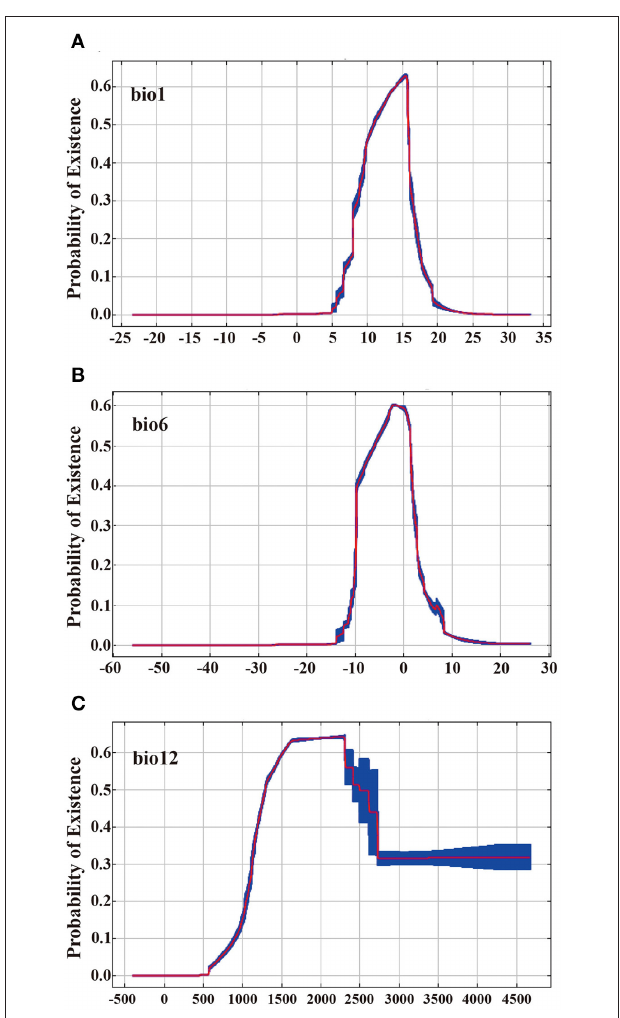
FIGURE 3 | Response curves between the probability of presence and climate variables (10 runs). (A) response curves between the probability of presence and bio1. (B) response curves between the probability of presence and bio6. (C) response curves between the probability of presence and bio12. Red: mean. Blue: mean ± 1 standard